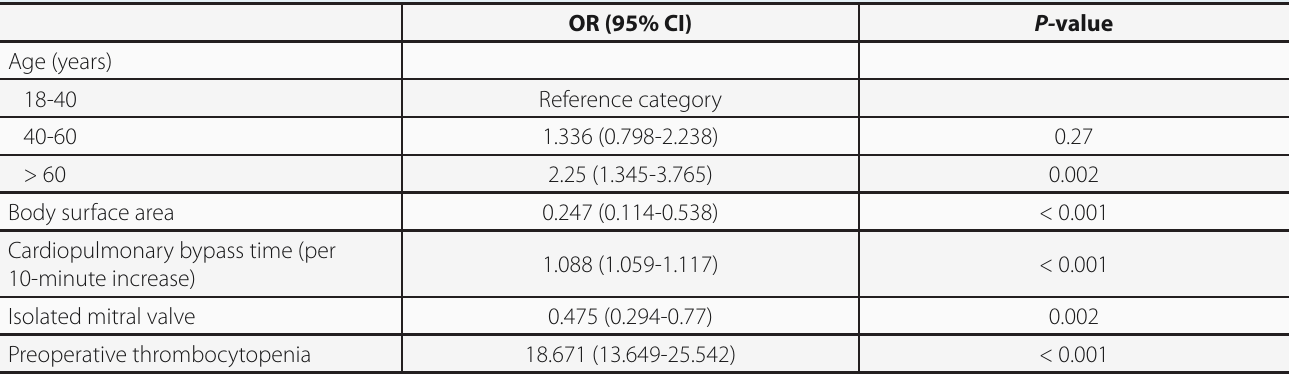
Table 4. Multivariable analysis for postoperative